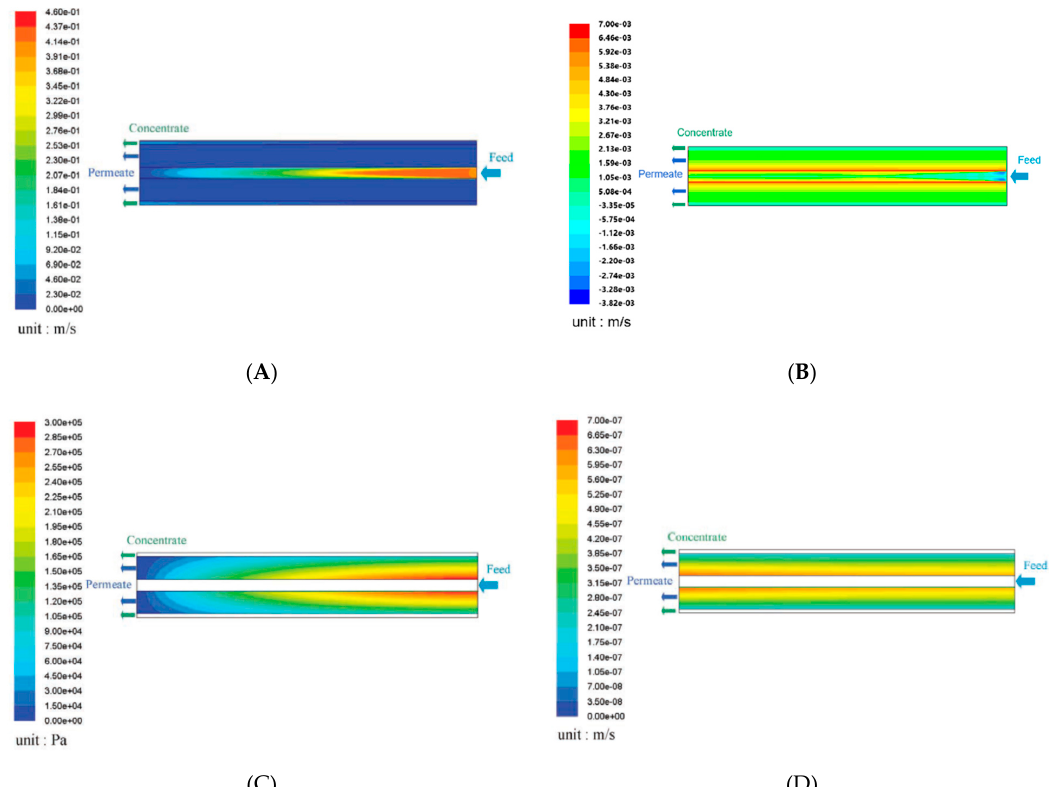
Figure 6. Simulation results by the computation fluid dynamics (CFD) using friction concentration polarization (FCP) model (i.e., CFD/FCP) for the single open-ended configuration (SOE) module. ( A ) Magnitude of shell side velocity in m/s. ( B ) Radial component of shell side velocity in m/s. ( C ) Bore side pressure in Pa. ( D ) Volumetric permeate flux in m/s. In the simulation, the inlet flow rate was 0.475 kg/s; salinity was 35 kg/m 3 ; the pressure at the outlet of the permeate side was fixed to be ambient pressure; the pressure at the outlet of the concentrated side was set to 5.5 MPa with a recovery ratio of 30%. Previously published as part of The International Desalination Association (IDA) World Congress Proceedings, San Diego 2015 [79].